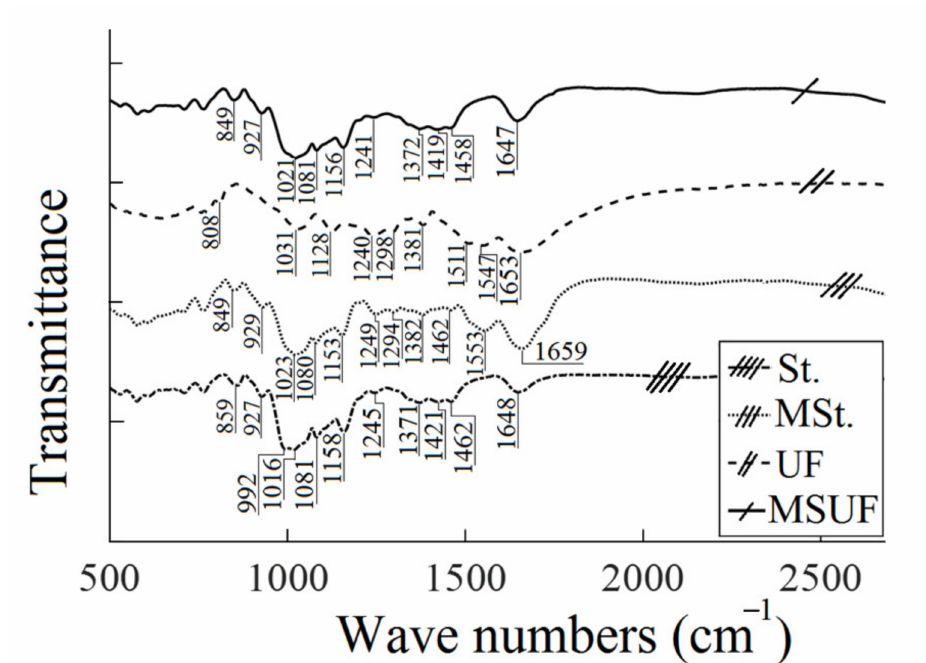
Figure 2. Infrared spectrograms of natural corn starch (St.), oxidized starch (MSt.), urea formaldehyde resin (UF), and mix of oxidized starch and UF (MSUF)